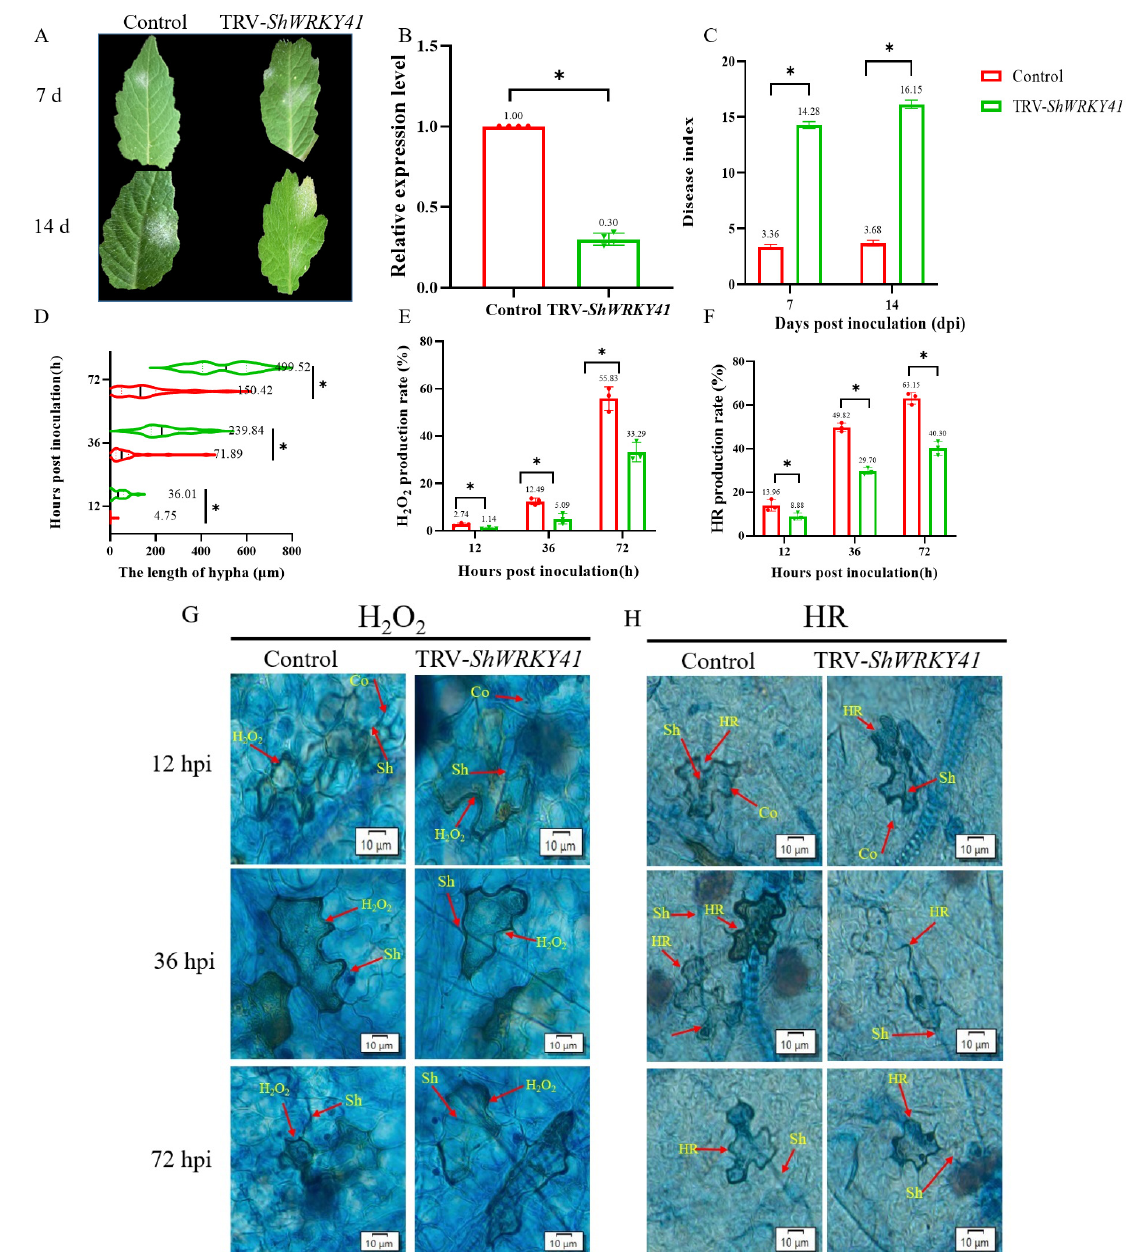
Figure 7. The silence of ShWRKY41 reduces the resistance of wild tomato LA1777 against On -lz. In the figure, the red legend represents the data from tomato LA1777 seedlings and the green legend represents the data from ShWRKY41 -silenced LA1777 seedlings. ( A ) Phenotype of TRV (control) or TRV- ShWRKY41 -silenced seedings under On -lz infection at 7&14-day-post-inoculation. ( B ) The efficiency of ShWRKY41 silencing in LA1777 seedlings. ( C ) The quantification of disease TRV- ShWRKY41 -silenced or control LA1777 seedlings at 7- and 14-day-post-inoculation with On -lz. ( D ) The statistics of O. neolycopersici hypha on ShWRKY41 -silenced or control LA1777 seedlings. ( E ) The H 2 O 2 production rate in ShWRKY41 -silenced or control LA1777 seedlings under On -lz infection. ( F ) The HR induction rate in ShWRKY41 silenced or control LA1777 seedlings under On -lz infection. The asterisk indicates statistically significant differences at level α = 0.05 with Student’s t -test between control and TRV- ShWRKY41 -silenced wild tomato LA1777 seedlings. ( G , H ) The microscopic detection of H 2 O 2 and HR accumulations at interaction sites of O. neolycopersici with control and silenced ShWRKY41 , respectively. Co, conidium; Sh, secondary hyphae. Bar, 10 mm.